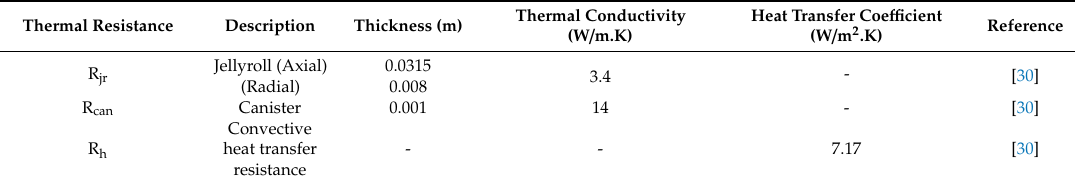
Table 4. Description of all thermal resistances within the individual cell and battery